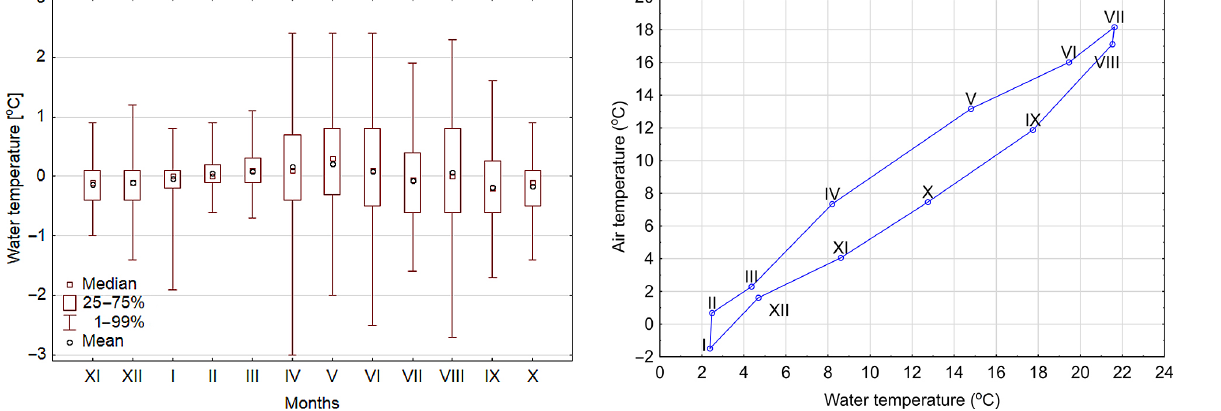
Kierskie in particular months.